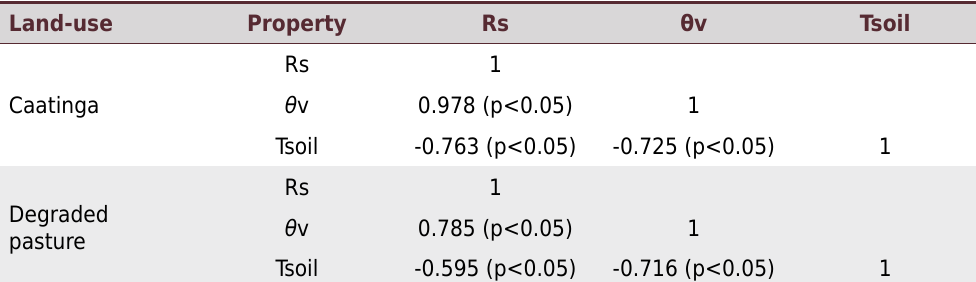
Table 2. Correlations between soil respiration (SR), soil moisture (θv), and soil temperature (Ts) in Caatinga and degraded pasture